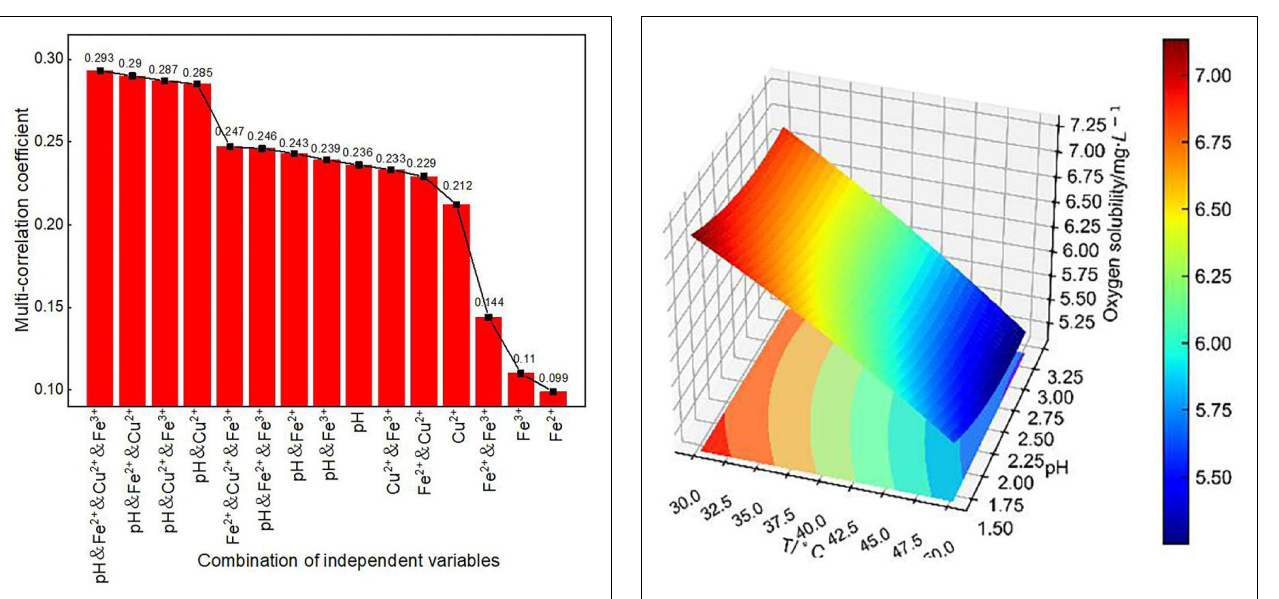
FIGURE 6 | Multi-correlation coefficients of factor combinations without temperature.